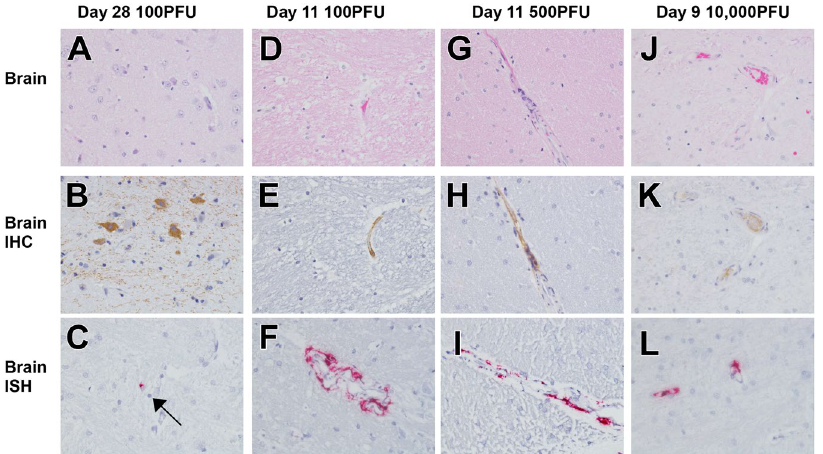
Figure 4. Representative histologic lesions in the brain of cynomolgus macaques infected with EBOV Makona variant via conjunctival route. Representative tissues of cynomolgus macaques from 100 PFU, survivor (100- 6) ( A – C ) and succumbed 11 dpi (100-4) ( D – F ), 500 PFU, succumbed 11 dpi (500-4) ( G – I ) and 10,000PFU, succumbed 9 dpi (10K-6) ( J – L ). All images captured at 40×. Hematoxylin and eosin (H&E) staining ( A , D , G , J ), immunohistochemistry (IHC) for anti-EBOV antigen ( B , E , H , K ), in situ hybridization ( C , F , I , L ). Mild gliosis ( A , D , G , J ). Diffuse cytoplasmic immunolabeling for anti-EBOV antigen in neuronal cells (B, brown), endothelium of small caliber vessels ( E , H , K ). Punctate labeling (red) in a single neuronal cell of 100 PFU survivor (100-6) (c, black arrow) and endothelium of small caliber vessels ( F , I , L